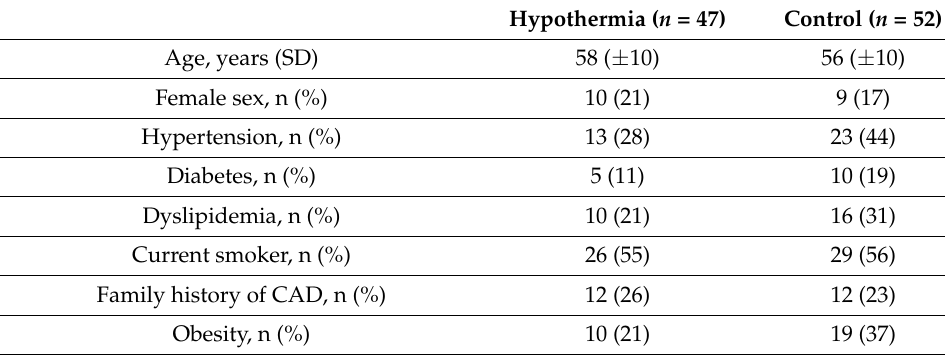
Table 1. Baseline